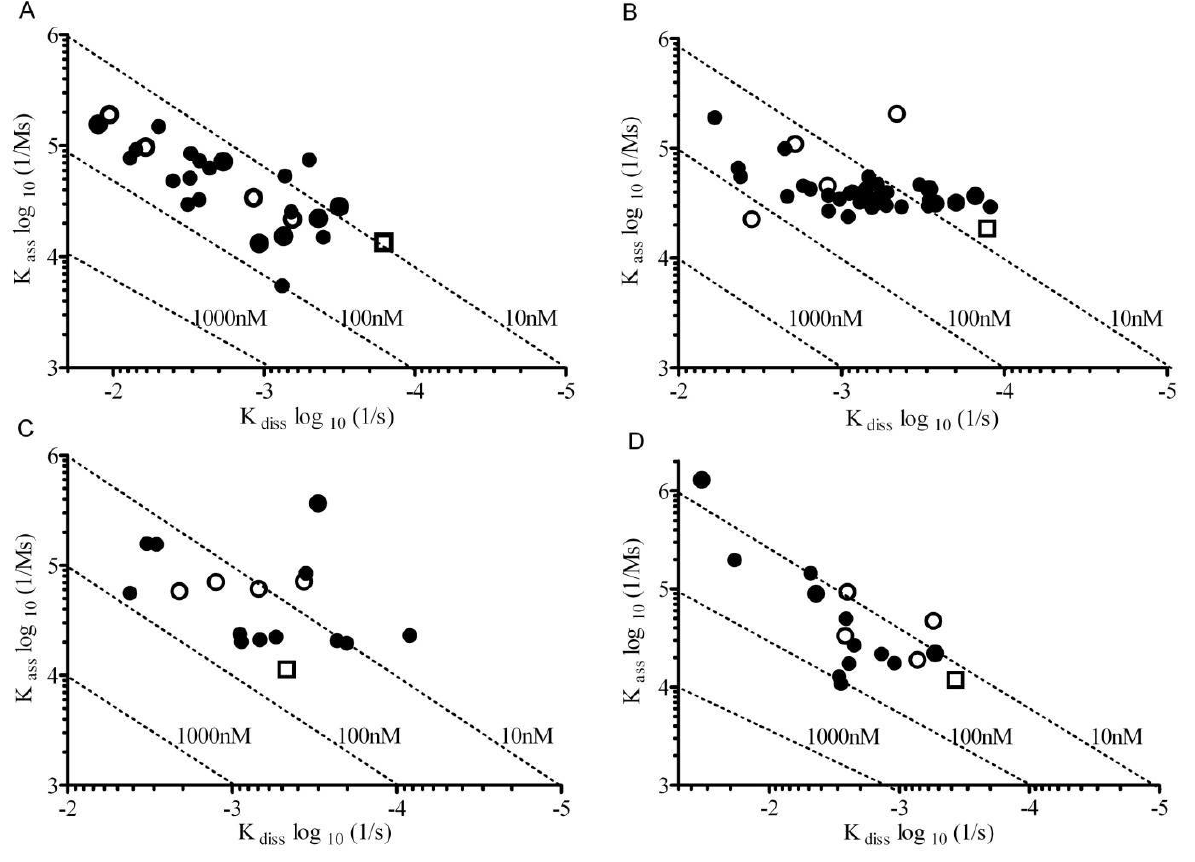
Figure 4. On-off rate plots of mAbs for DENV NS1 determined using Surface Plasmon Resonance (SPR). ( A ) DENV-1 NS1 reactive mABs, ( B ) DENV-2 NS1 reactive mABs, ( C ) DENV-4 NS1 reactive mABs, and ( D ) DENV-4 NS1 reactive mABs. The dotted diagonal lines represent affinities (k /k ). Open circles represent mAbs reactive with all diss ass four dengue NS1 serotypes. Open squares represent the commercial Alere mAb used for comparison.